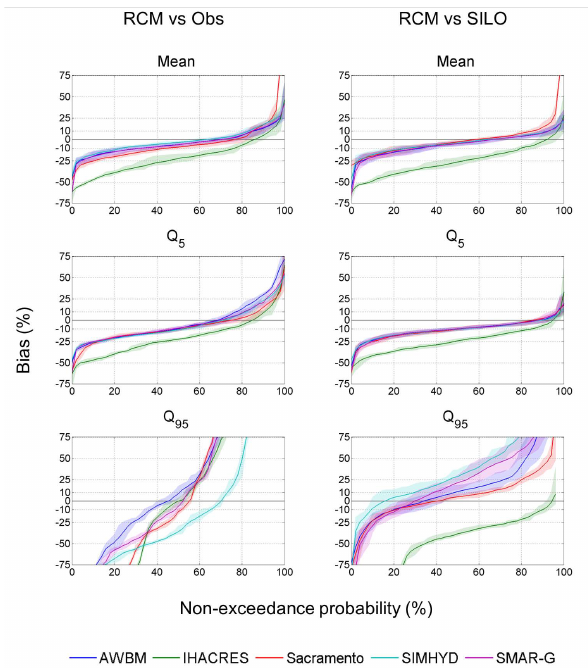
Fig. 6. Non-exceedance probabilities of streamflow biases from the hydrological models forced with the RCM at 86 streamflow gauges for 1961–2007. Left column shows biases calculated against ob- served streamflows, right column shows biases calculated against streamflows simulated with the hydrological models forced by SILO variables. Biases are shown for mean streamflows (top row), high ( Q 5 ) streamflows (middle row) and low ( Q 95 ) streamflows (bottom row). Lines show mean biases from the six RCM simula- tions, shaded confidence intervals show the range of biases from the six simulations. For left panels positive biases mean that RCM- forced runoff overestimates observations, and for right panels pos- itive biases mean that RCM-forced runoff overestimates SILO- forced